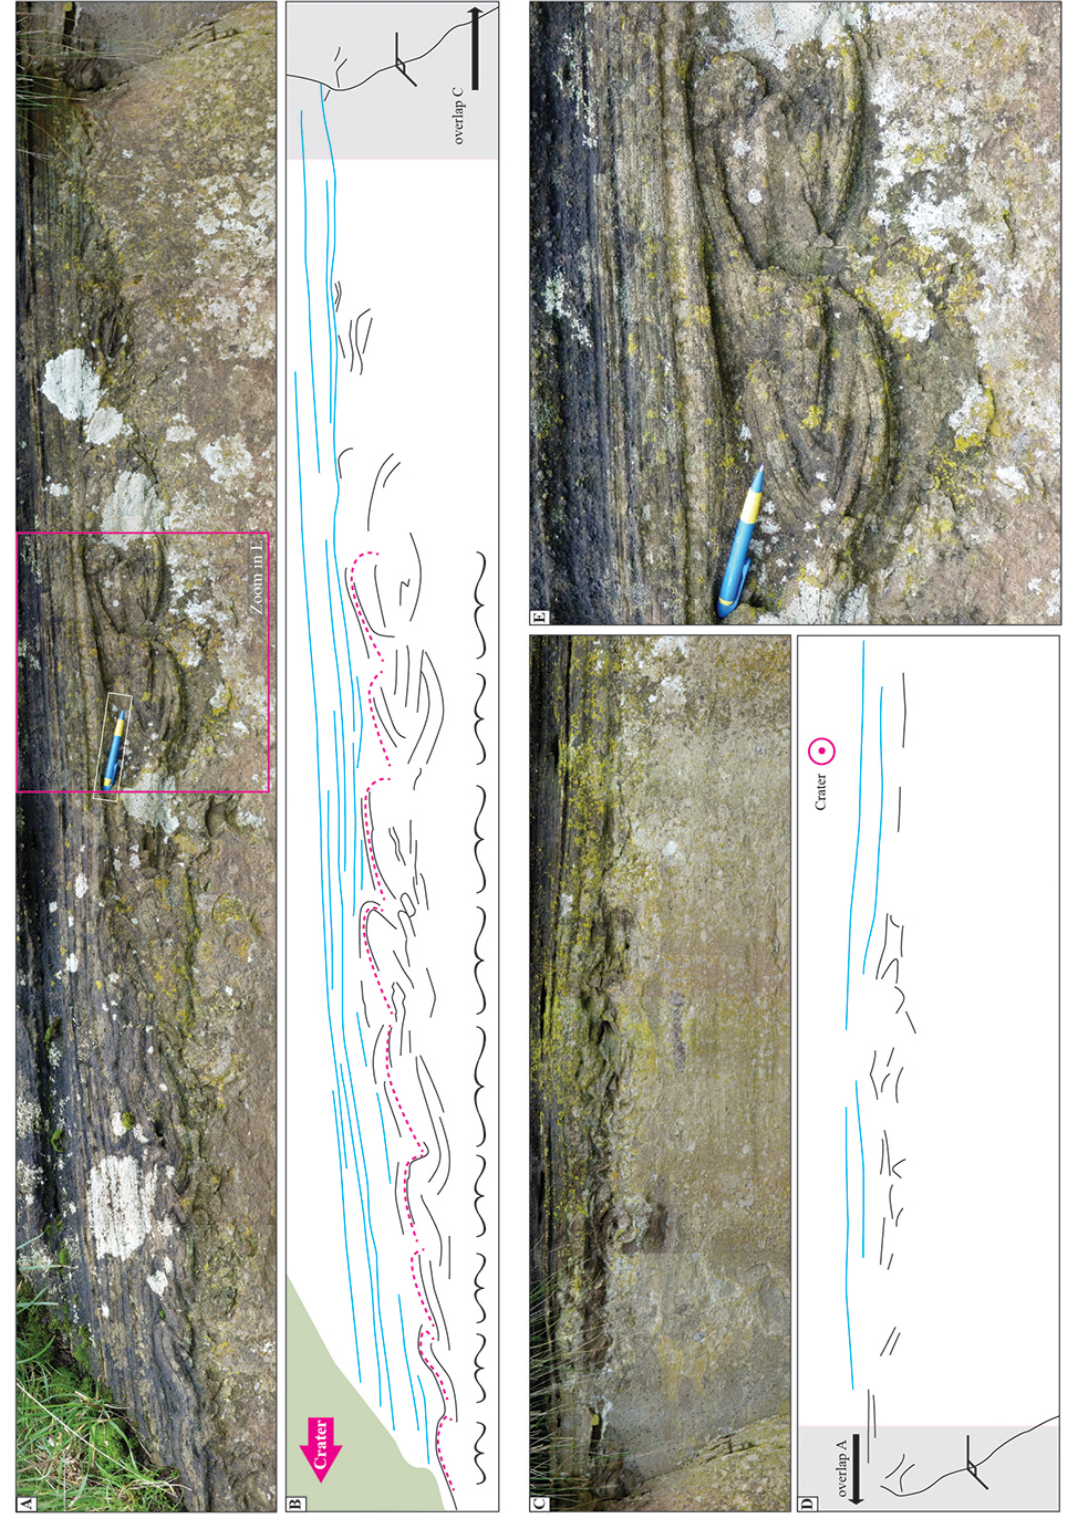
Figure 6. SSD at Purrumbete rim interpreted as related to shock waves. (a) Outcrop part oriented outward crater showing folds-and-faults with (b) interpretation; pink dashed lines highlight a pseudo recurrence and brackets a pseudo wavelength. Shaded zones indicates the overlap with (c) , the outcrop part oriented parallel to rim showing chaotic, diapiric flame-like structures with (d) interpretation. (e) Zoom into recumbent folds-and-faults structures with overlying planar lamination (location outlined in a ). Solid Earth, 6, 553–572, 2015